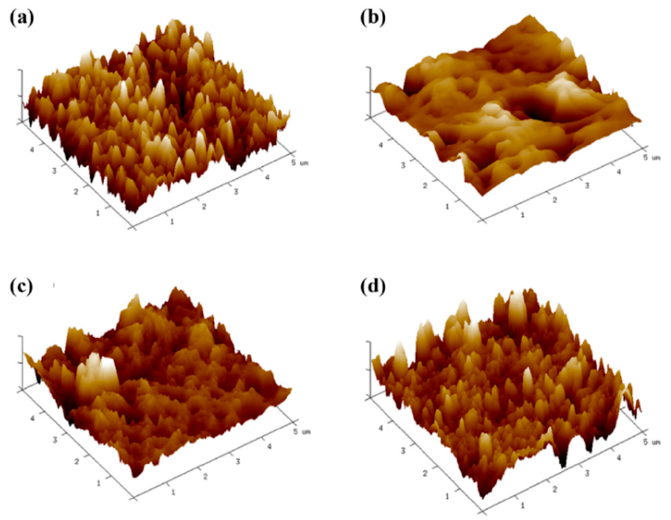
Figure 2. AFM diagrams of TFC-FO membranes, ( a ) GO-0, ( b ) TFC-FO PSF/GO , ( c ) TFC-FO PA/GO , ( d ) TFC-FO PSF-PA/GO.